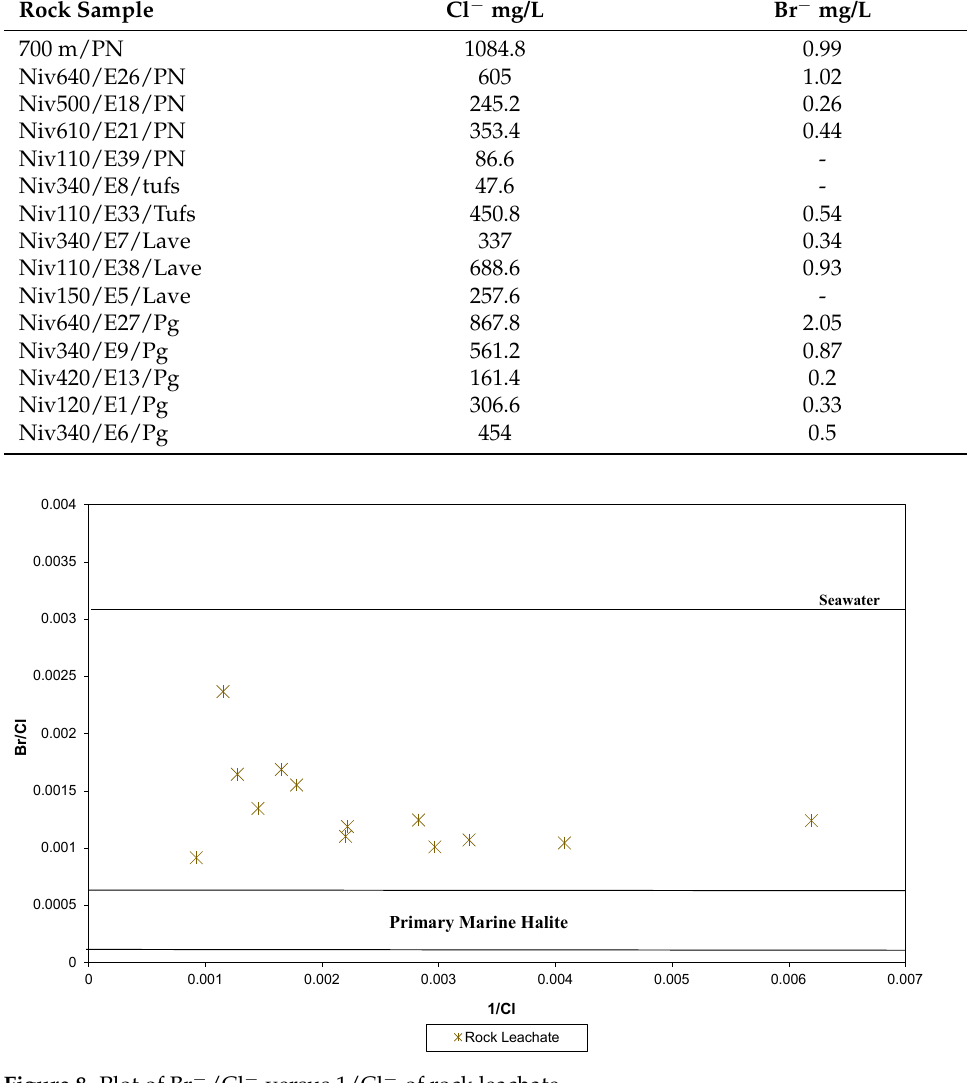
Table 3. Cl − and Br − concentrations in rock leachate.